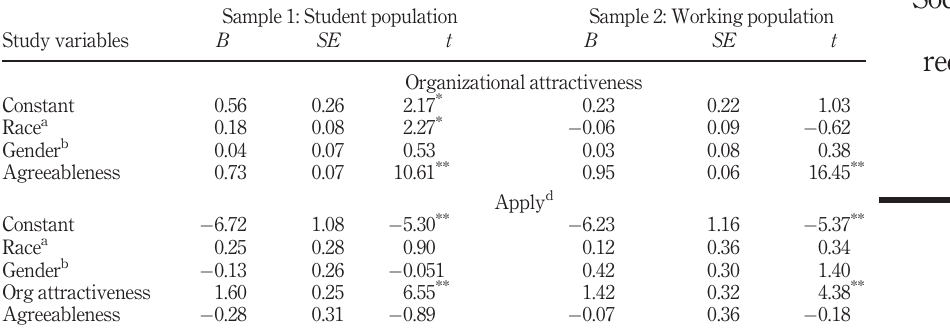
Table 4. Regression analysis testing relationships among